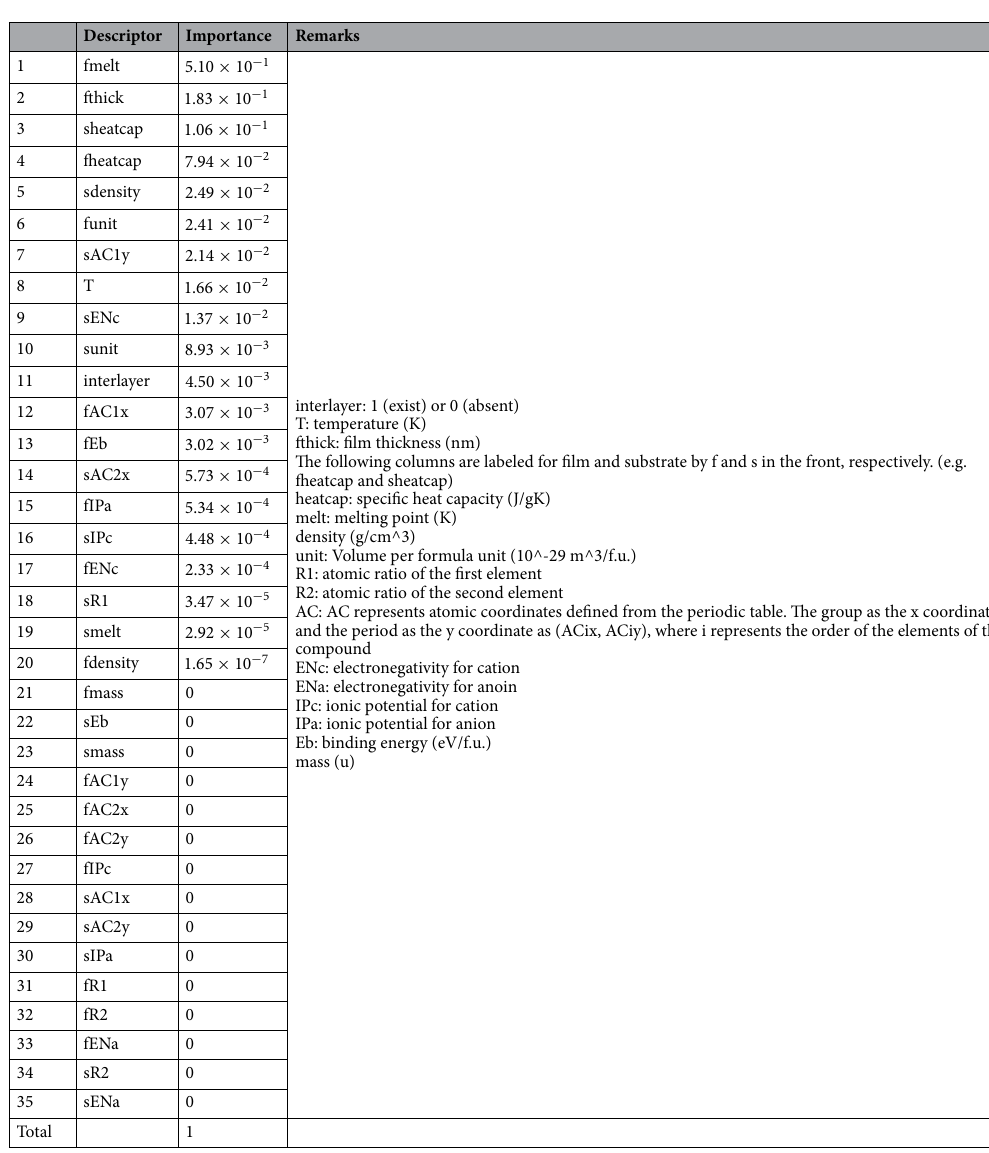
Table 1. Descriptor importances from decision tree.